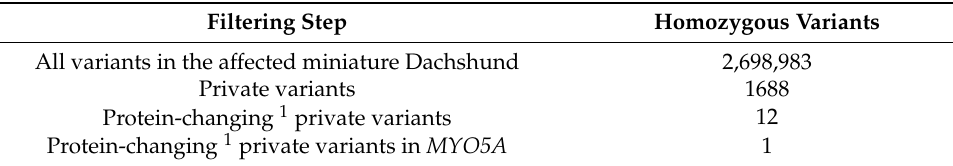
Table 1. Results of variant filtering in the affected miniature Dachshund dog against 795 control genomes.